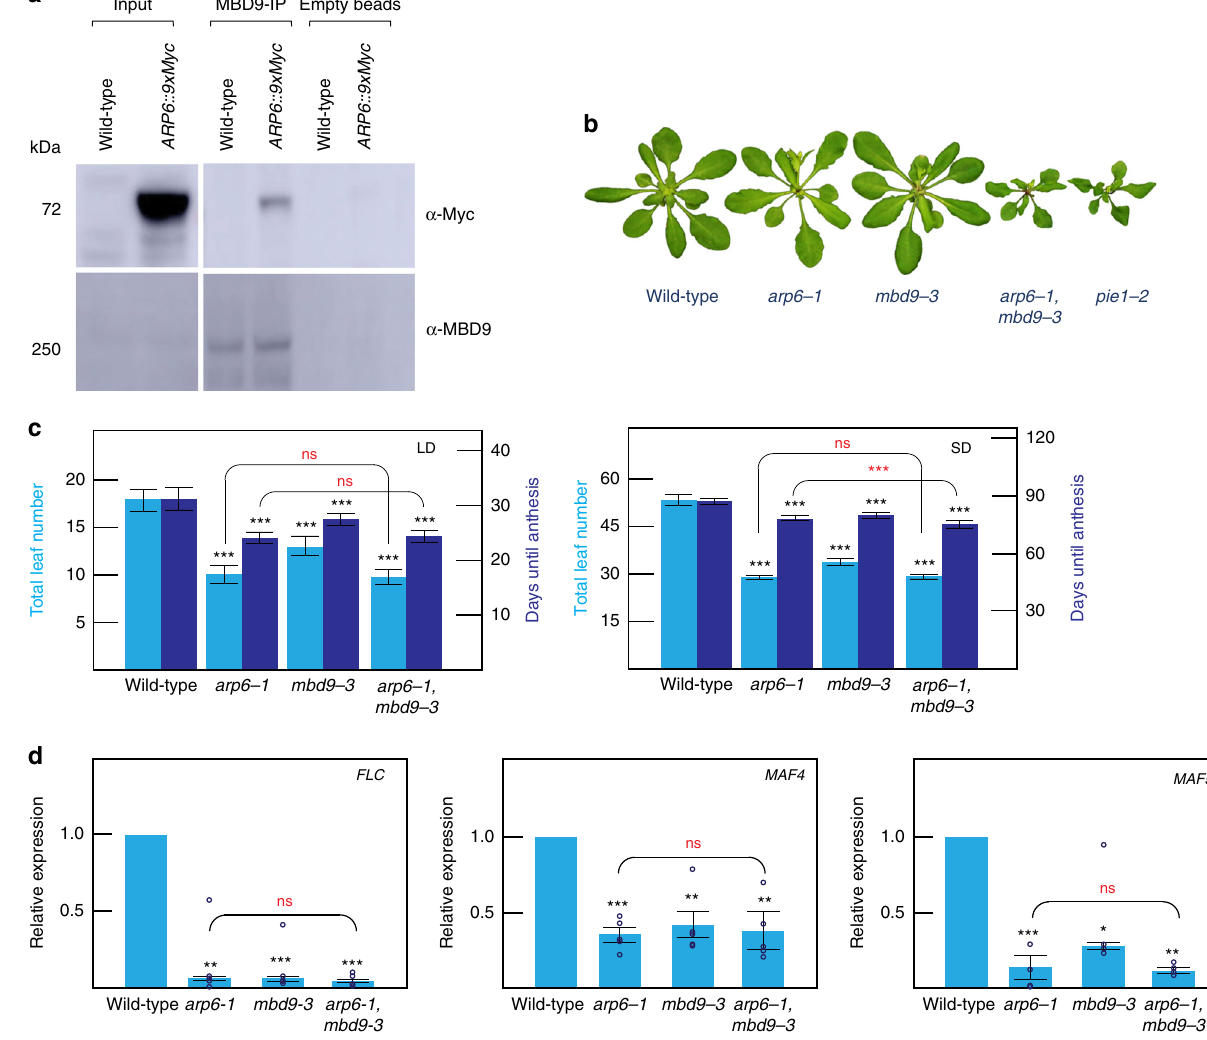
Fig. 1 ARP6 and MBD9 interaction and phenotype of the mutants. a Pull-down and co-immunoprecipitation assay. Empty bead lanes serve as negative controls. For each western blot, the antibody used is indicated to the right. b Phenotype of arp6-1 , mbd9-3 , arp6-1 mbd9-3 , and pie1-2 mutants. Plants were grown for 4 weeks ( b ) or 5 weeks ( c ) under long-day (LD) conditions (16 h light, 8 h dark) and short-day (SD) conditions (8 h light, 16 h dark). Flowering time expressed as the number of days from germination to anthesis as well as the total number of leaves produced by wild type, arp6-1 , mbd9-3 , and arp6-1 mbd9-3 under the same conditions are shown. Averages from 16 plants ± standard deviations are shown. Paired two-tailed Student ’ s t -test was used to determine signi fi cance between wild type and mutants (black asterisks) or between mutants (red asterisks); ns p value >0.05, * p value ≤ 0.05, ** p value ≤ 0.01, *** p value ≤ 0.001. d Relative expression levels of FLC , MAF4 , and MAF5 in wild type, arp6-1 , mbd9-3 , and arp6-1 mbd9-3 . UBQ10 was used as an internal control for expression analyses. Average expression levels from three independent replicates ± standard deviations are shown. Paired two-tailed Student ’ s t -test was used to determine signi fi cance between wild type and mutants (black asterisks) or between mutants (red asterisks); ns p value